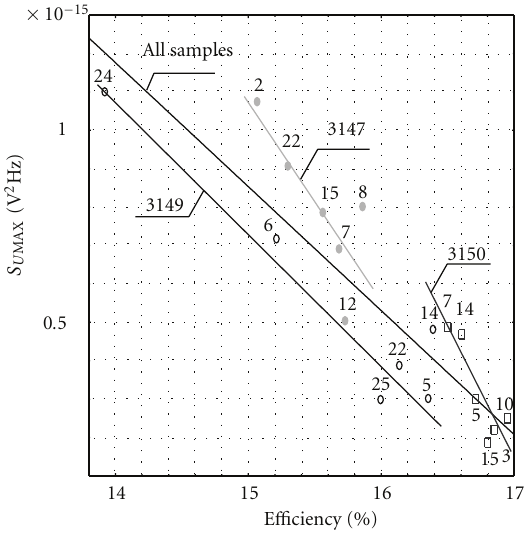
Figure 6: The correlation between spectral voltage density S U MAX and conversion e ffi ciency of the solar cells from all groups.